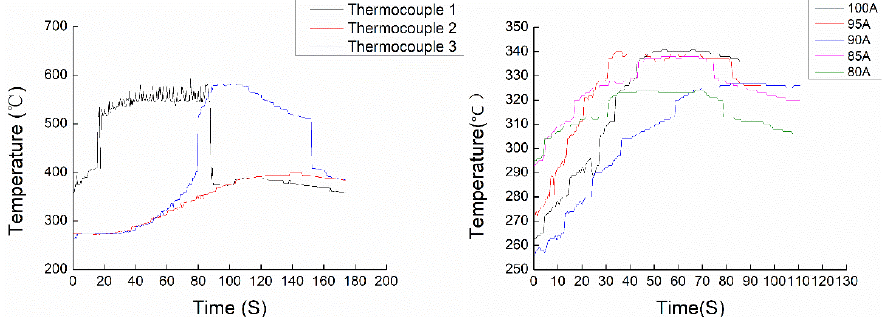
Figure 5. The temperature profiles of different locations and the middle part of the specimen.